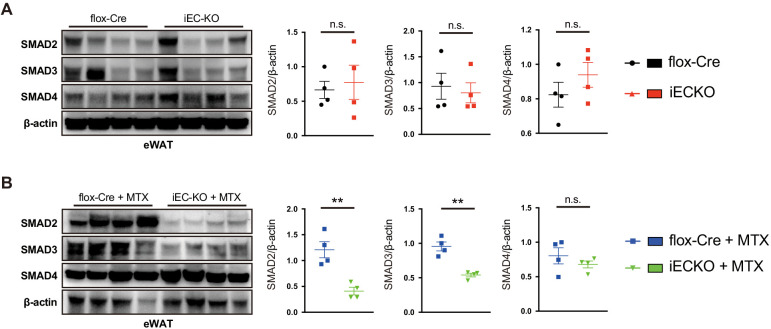
Western blot analysis of SMADs expression in eWAT from high-fat diet (HFD)-fed flox-Cre and iEC-KO mice treated with or without methotrexate (MTX) for 12 weeks.(A) Western blot analysis of Smad2, Smad3, and Smad4 expression in eWAT tissues from HFD-fed control flox-Cre and iEC-KO mice for 12 weeks. (B) Western blot analysis of Smad2, Smad3, and Smad4 expression in eWAT tissues from HFD-fed control flox-Cre and iEC-KO mice treated with MTX for 12 weeks. (A and B), n = 4 mice per group. **p<0.01. All values represent mean ± SEM.